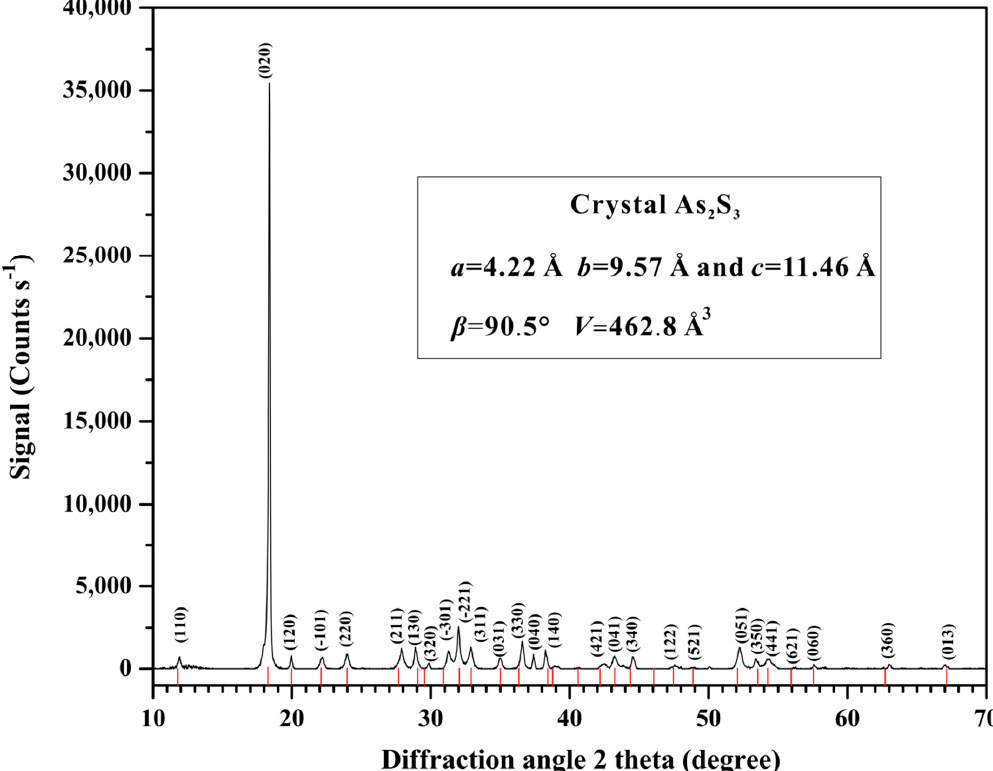
Figure 1. The X-ray diffraction of orpiment under ambient conditions.